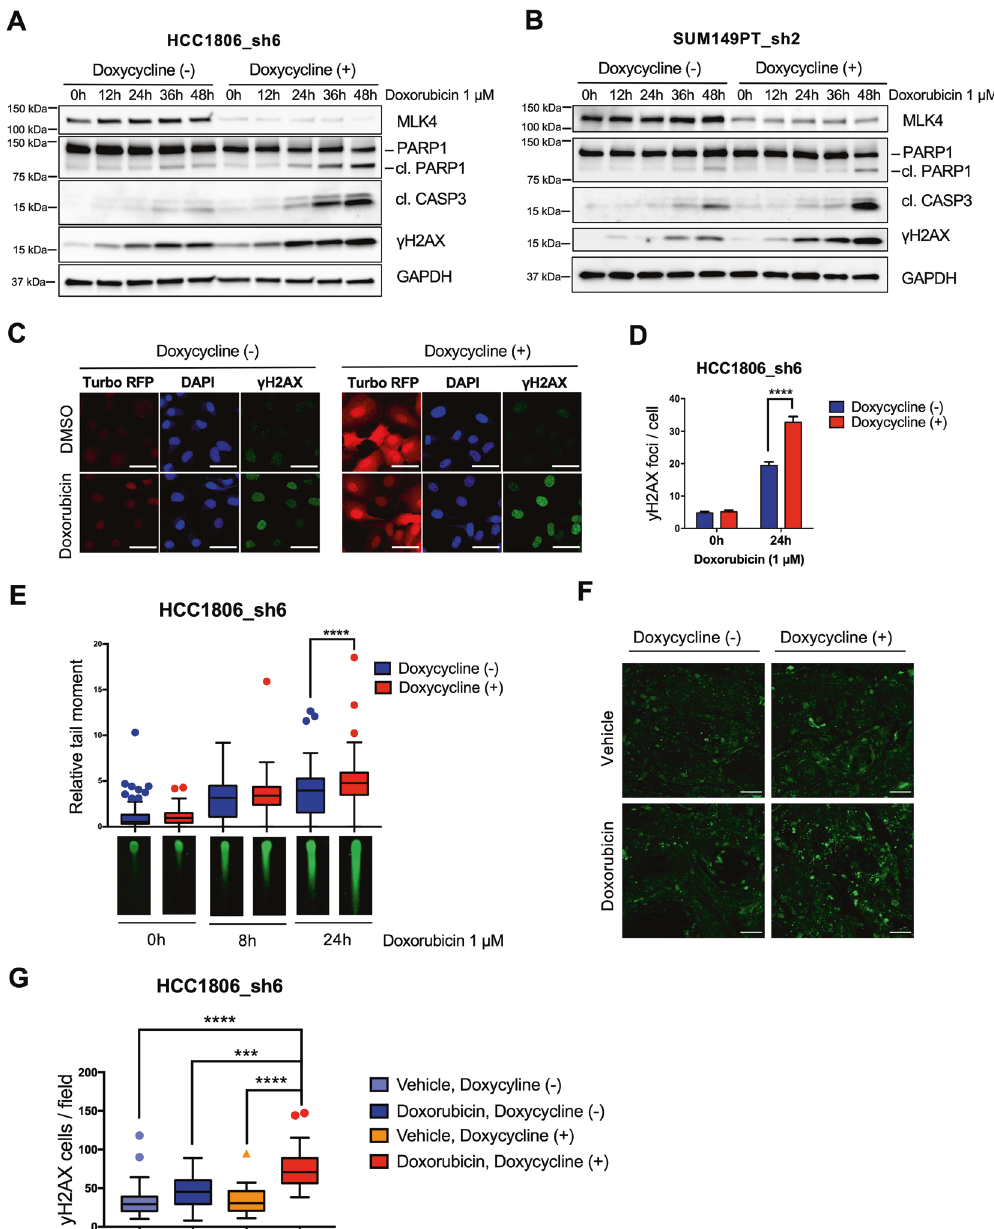
Fig. 4 MLK4 loss results in an accumulation of doxorubicin- induced DNA damage in TNBC cells. A – B MLK4 knock-down was induced by doxycycline in HCC1806_sh6 and SUM149PT_sh2 and subsequently cells were treated with doxorubicin for the indicated time. Following the treatment, whole cell lysates were collected and analyzed by immunoblotting. The persistent phosphorylation of γ H2AX in MLK4-depleted cells was associated with apoptotic cell death, as suggested by caspase 3 activation and PARP1 cleavage. C HCC1806_sh6 cells were incubated with doxycycline to induce MLK4 knock-down, treated with doxorubicin for 24 h and stained for γ H2AX [green] and DAPI [blue]. The expression of turbo-RFP [red] is induced along with the expression of MLK4-targeting shRNA. Scale bars 50 μ m. D Nuclear foci of γ H2AX were quanti fi ed in at least 50 cells in each group per experiment using FIJI. Error bars indicate ±SEM from three independent experiments. Signi fi cance was calculated using an unpaired two-tailed t -test, **** p < 0.0001. E HCC1806_sh6 cells were incubated with doxycycline to induce MLK4 knock-down and treated with doxorubicin for 8 h or 24 h. After the treatment, the extent of DNA damage was analyzed by neutral comet assay. Relative comet tail moment was quanti fi ed in at least 50 cells in each group per experiment using ImageJ Open Comet plugin. Error bars indicate ±SEM from three independent experiments. Signi fi cance was calculated using an unpaired two-tailed t -test, **** p < 0.0001. F HCC1806_sh6 xenograft tumors were harvested and stained for γ H2AX [green]. Scale bars 50 μ m. G γ H2AX-positive cells in tumor sections were quanti fi ed using FIJI. Signi fi cance was calculated using one-way ANOVA followed by Tukey multiple comparisons test, *** p < 0.001, **** p < data and showed that both MLK4 knock-down and doxorubicin expression pro fi ling by mRNA-seq in HCC1806 cells transfected treatment led to signi fi cant transcriptome-wide alterations in with control or MLK4-targeting siRNAs and treated with either HCC1806 cells (Supplementary Fig. S8A). Differential gene expres- doxorubicin for 24 h or vehicle only. Principal component analysis sion analysis revealed that approximately 25% of transcripts (PCA) con fi rmed a high degree of reproducibility of our mRNA-seq